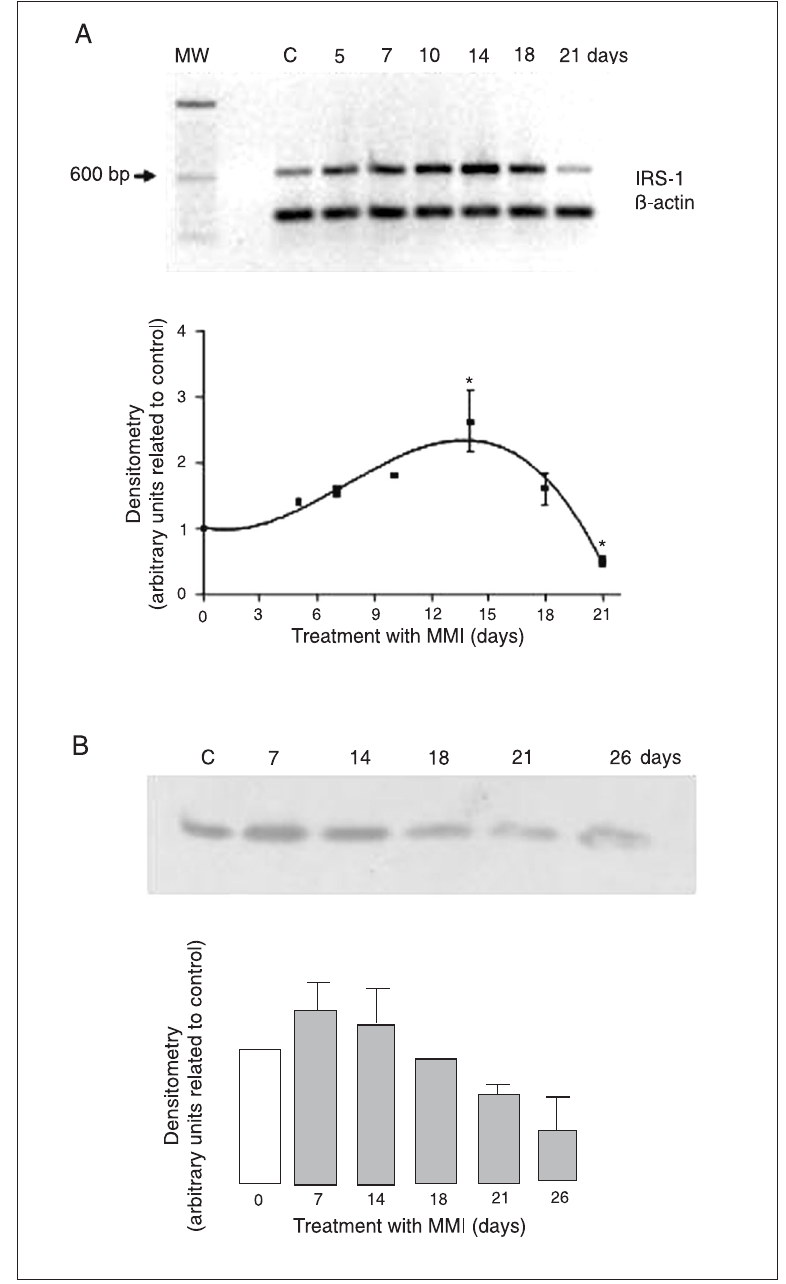
Figure 2. Thyroid insulin receptor substrate-1 (IRS-1) mRNA (A) and protein (B) expression during goitrogenesis in rats. Thyroid IRS-1 mRNA expression (A) was analyzed by semi- quantitative RT-PCR and IRS-1 protein expression (B) was analyzed by immunoprecitation followed by immunoblotting with anti-IRS-1 antibody. Goiter was induced by treatment with 0.03% methimazole (MMI) in drinking water for different periods of time (5, 7, 10, 14, 18, 21, and 26 days). Data are reported as the mean ± SEM of 2-3 rats per group in three experiments in A and the mean and the maximal value of two different experiments in B . *P < 0.01 compared to control (C, 14 days) and to the other periods of MMI treatment (21 days; ANOVA followed by the Newman-Keuls multiple comparison test). MW = molecular